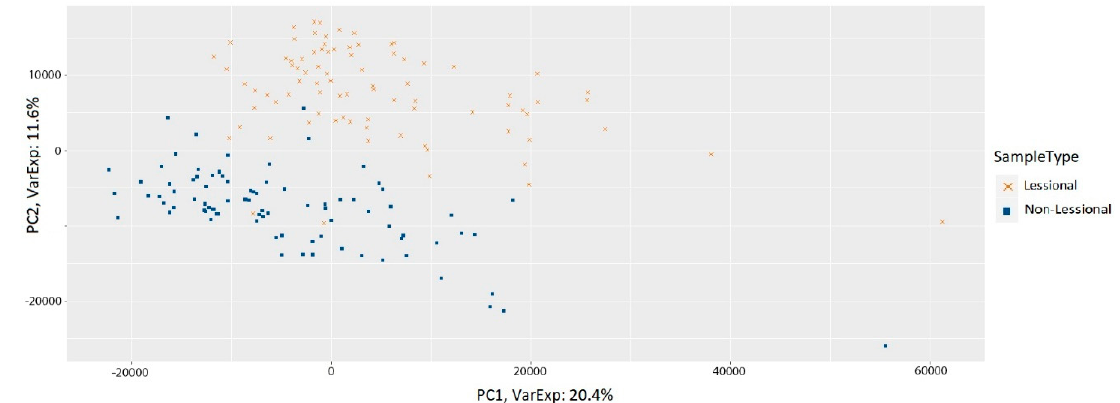
Figure 2. PCA of gene expression values of all samples after normalization. PCA analysis conveys an overall certain discrimination associated with gene expression levels between the two sample types.